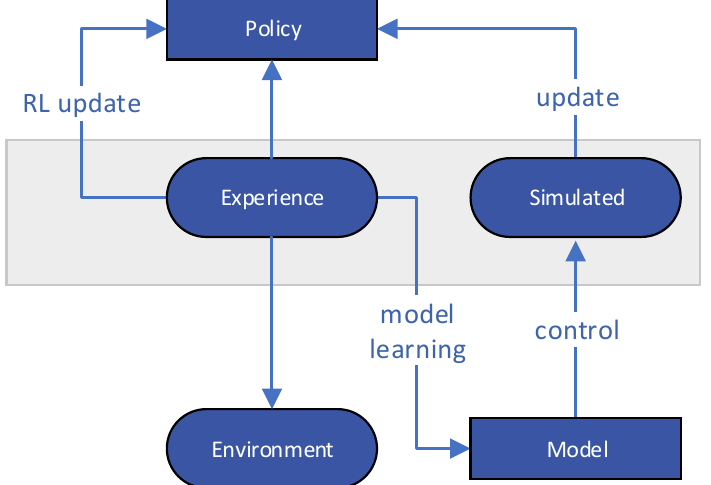
Figure 1. Reinforcement Learning (RL)